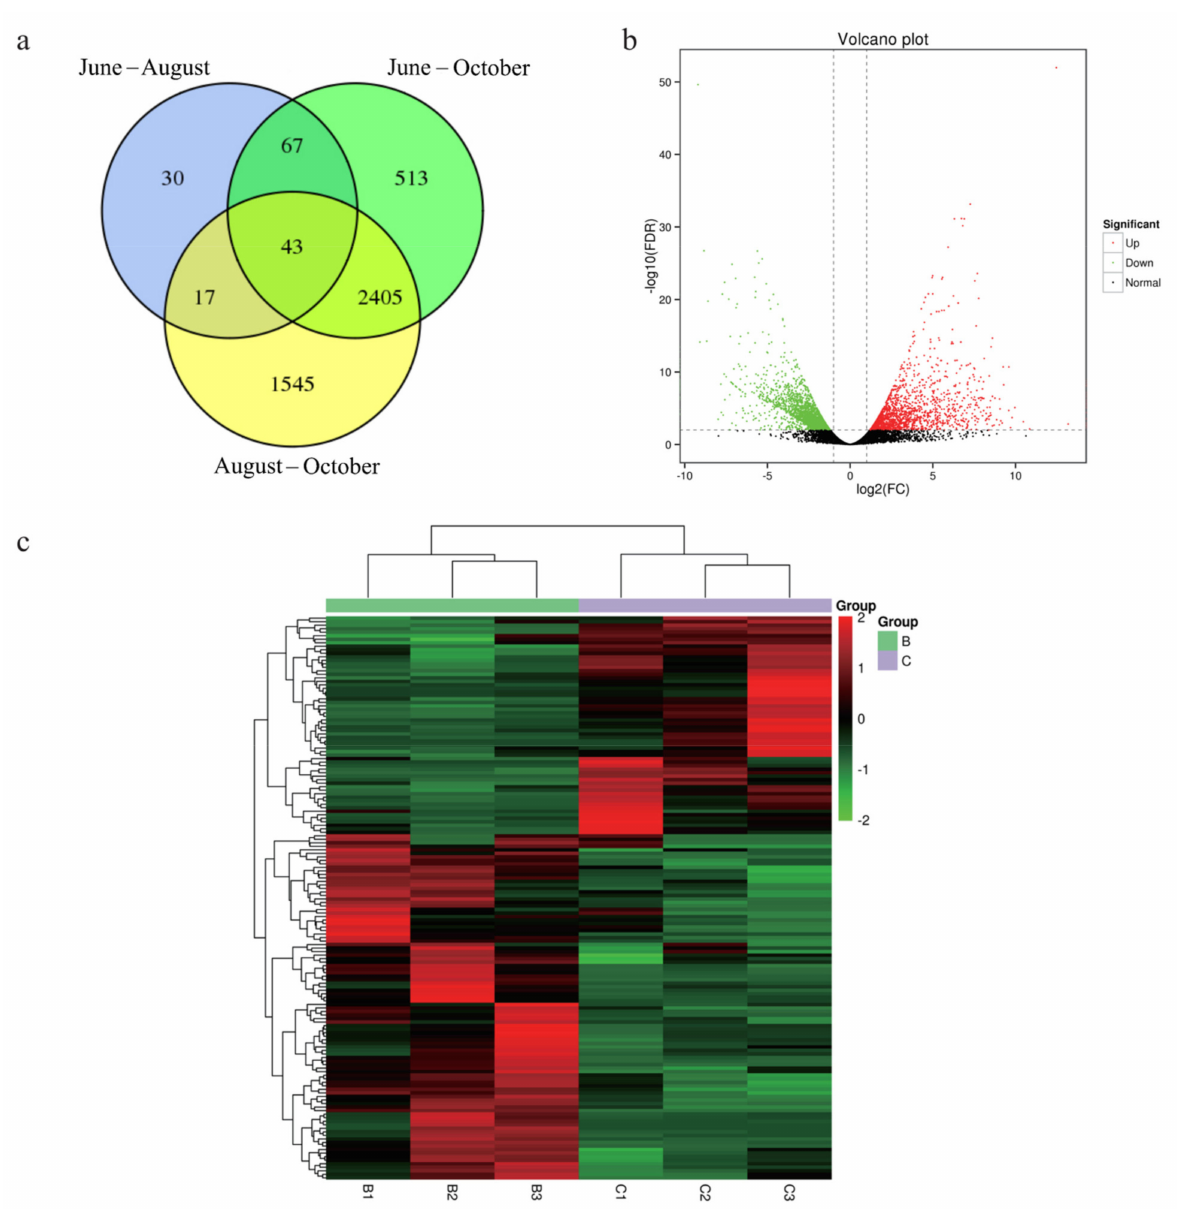
Figure 5. Results of differentially expressed genes in G. biloba . ( a ): The Venn diagram of differential expressed genes (DEGs) across different periods. The overlap represents the same DEGs among different comparison groups. ( b ): Volcanic map of the differential genes between the second and third periods. Green dots represent down-regulated differentially expressed genes, red dots represent up-regulated differentially expressed genes, and black dots represent non-differentially expressed genes. ( c ): Heat map of gene expression between the second and third periods. B group represent the three samples at period 2 (August), and C group are those at period 3 (October) with red represents up-regulated